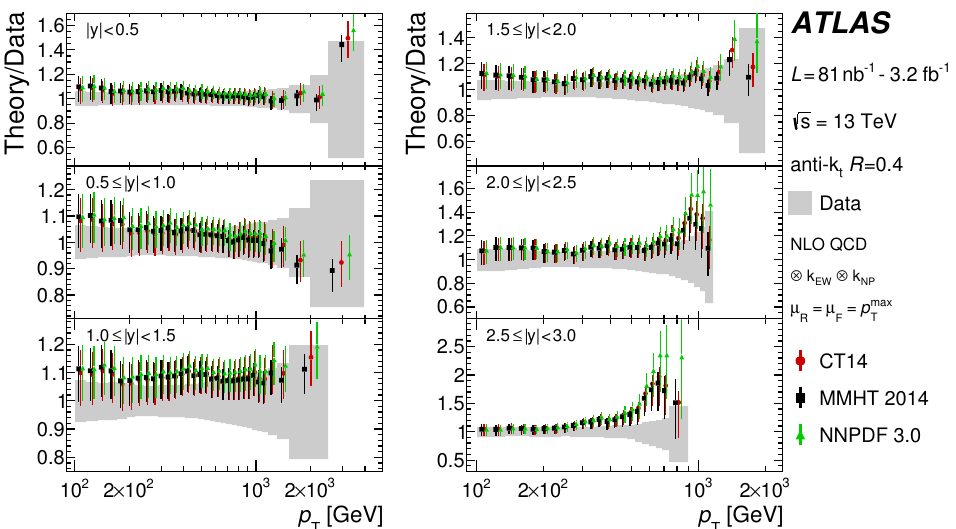
Figure 7 . Comparison of the measured inclusive jet cross-sections and the NLO pQCD predictions shown as the ratios of predictions to the measured cross-sections. The ratios are shown as a function of the jet p T in six j y j bins for anti- k t jets with R = 0 : 4. The predictions are calculated using NLOJET++ with three di(cid:11)erent PDF sets (CT14, MMHT 2014, NNPDF 3.0) and non- perturbative and electroweak corrections are applied. The uncertainties of the predictions, shown by the coloured lines, include all the uncertainties discussed in section 9. The grey bands show the total data uncertainty including both the systematic (JES, JER, unfolding, jet cleaning, luminosity) and statistical uncertainties.